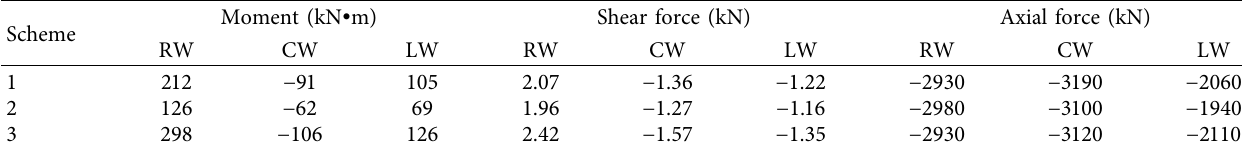
Table 3: The distribution of internal force at the wall center in the 3 schemes.